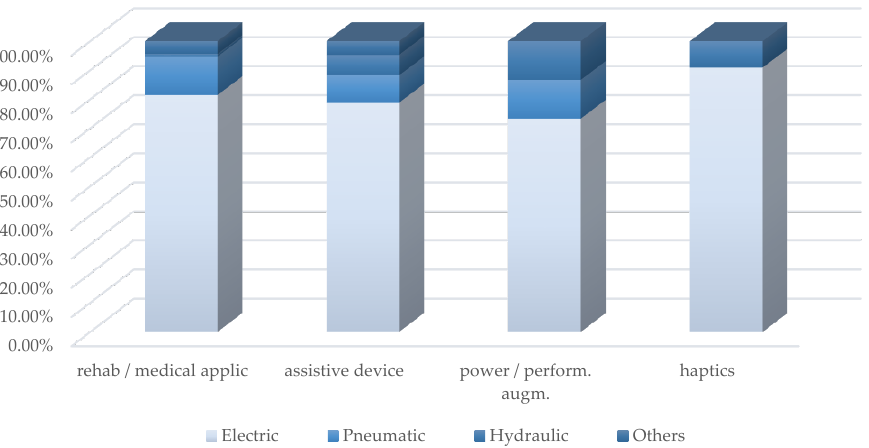
Figure 22. The distribution of the power source technologies for exoskeletons with different pur- poses. Electric actuation is the predominant choice regardless of the exoskeleton purpose (81%, 79%, 73% and 91% in the displayed order). Pneumatics has about 13% in medical applications and power/performance augmentation EDs (Exoskeletal Devices), and, in these last devices, hydraulics have a similar percentage